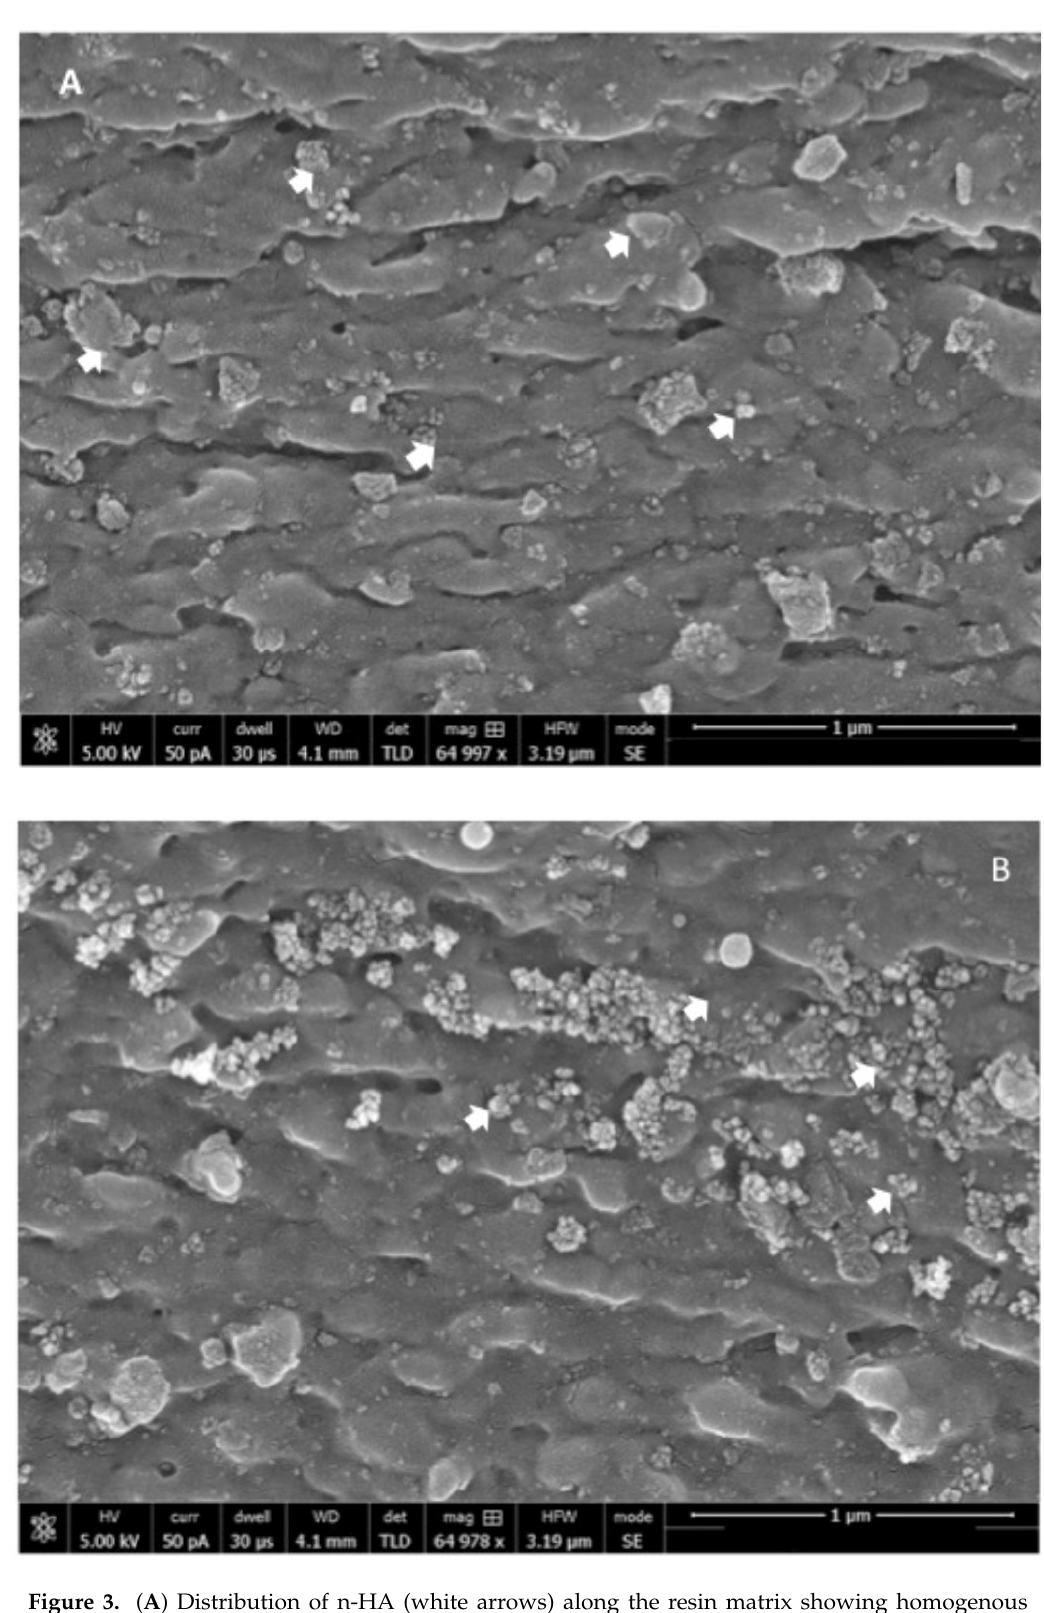
Figure 3. ( A ) Distribution of n-HA (white arrows) along the resin matrix showing homogenous dispersion of the low percentage weight (5 wt %) hydroxyapatite nanoparticles. ( B ) Distribution of n-HA (white arrows) in the resin matrix, showing dispersion of high percentage (10 wt %) with